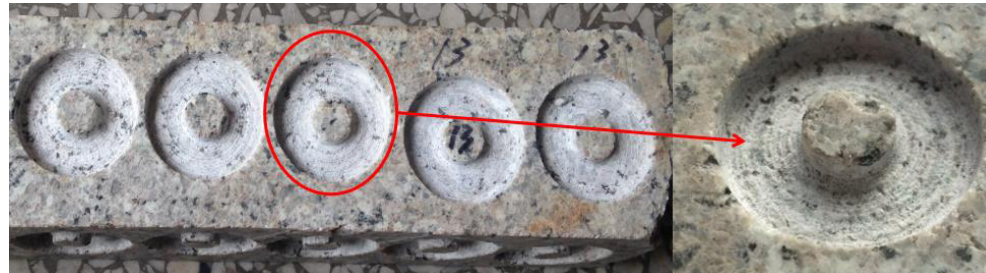
Figure 8. The micro bottom hole.